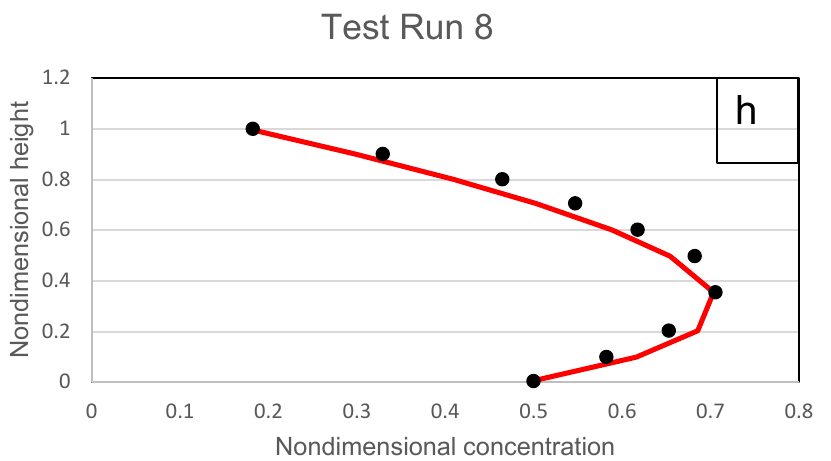
Figure 19. ( a – h ) The modelled results and comparisons for experimental data of Micahlik [36].